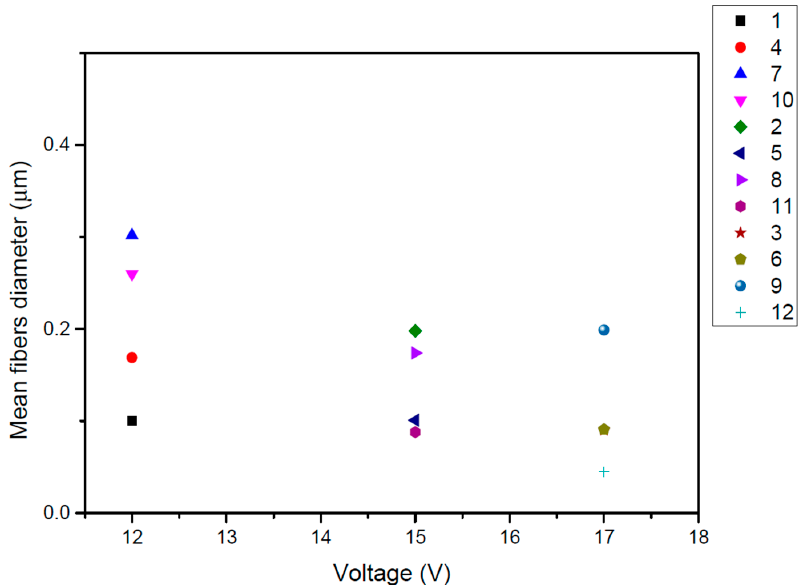
Figure 3. Effect of the applied voltage of the electric field on the fibers diameter ( μ m) for PCL (Mn 71.000) from 17% w/v chloroform solution for each investigated system of parameters.